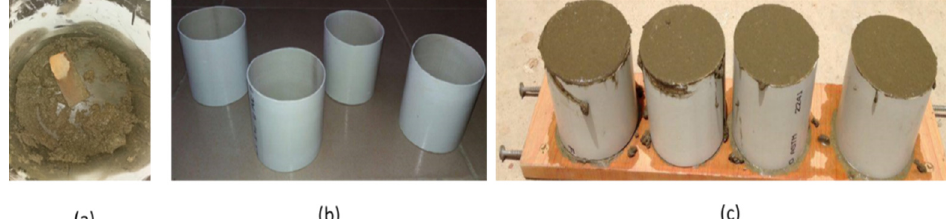
Fig. 2: Cement Mortar Block Making Procedure (a) Mixing of Ingredients, (b) PVC Pipe Sections as a Mold and (c) Cast Blocks